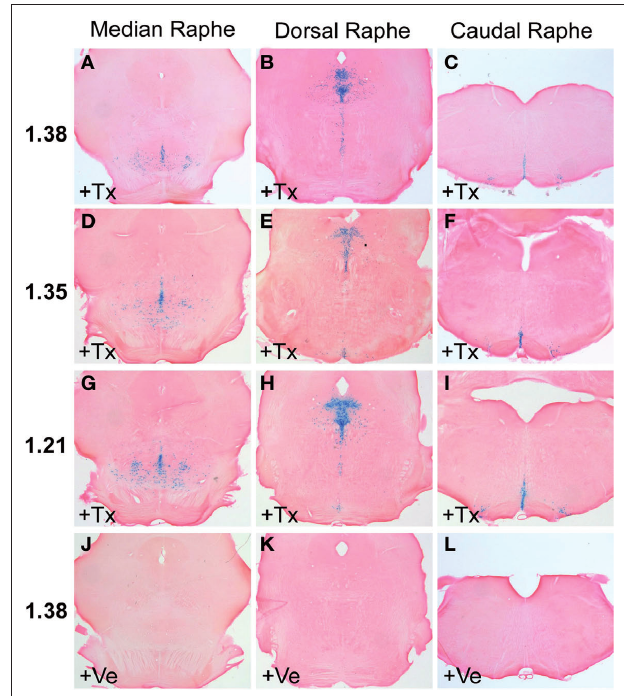
FIGURE 1 | TPH2-CreERT2 construct for DNA microinjection. A PCR-amplifi ed CreERT2.pA cassette fl anked by sequences (42 bp) homologous to the integration site of the PAC-based genomic Tph2 locus was recombineered in E. coli. CreERT2.pA was inserted into the ATG-start of Exon 1 of the mouse Tph2 gene.